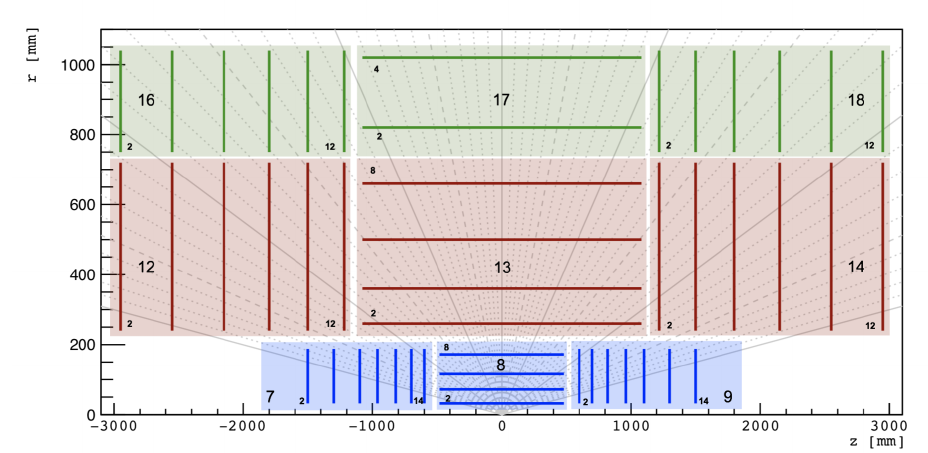
Figure 1. TrackML Detector Layout